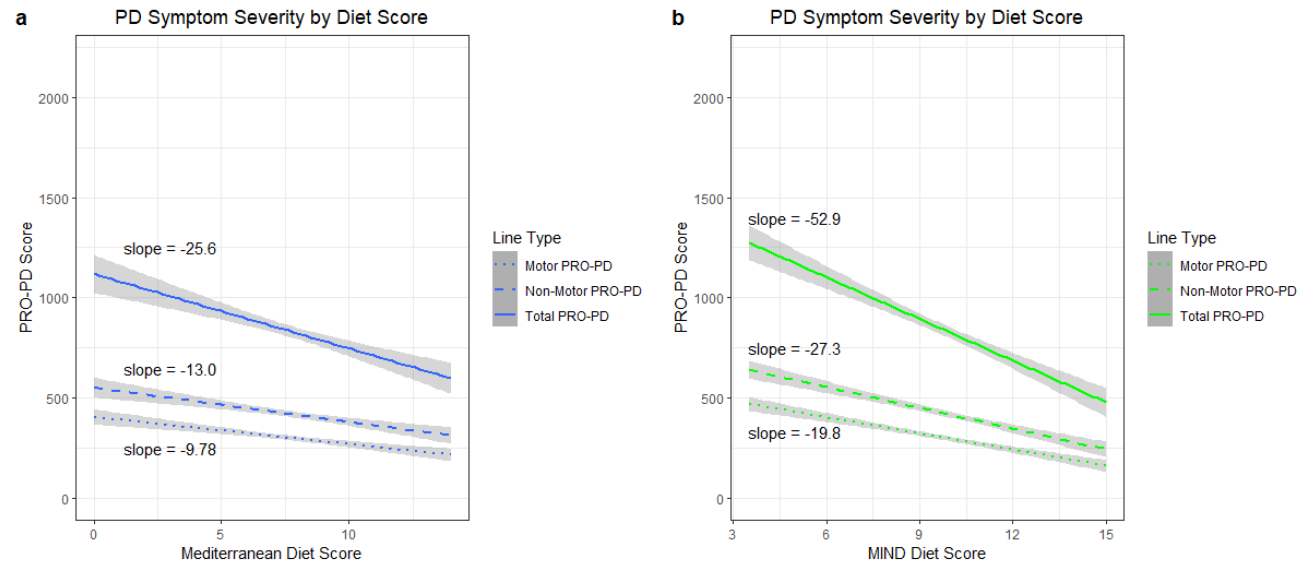
Figure 1. ( a ) Linear regression of PRO-PD score by Mediterranean Diet Score adjusted for age, gender, income, and years since diagnosis with non-motor and motor PRO-PD sub-scores. ( b ) Linear regression of PRO-PD score by MIND Score adjusted for age, gender, income, and years since diagnosis with non-motor and motor PRO-PD